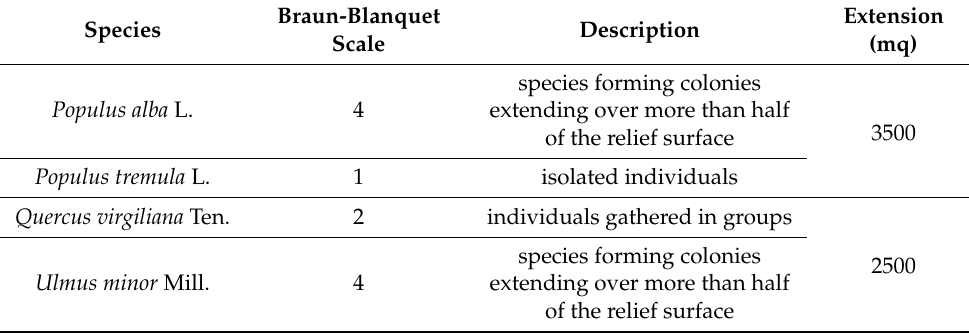
Table 1. Phytosociological analysis of the arboreal vegetation.